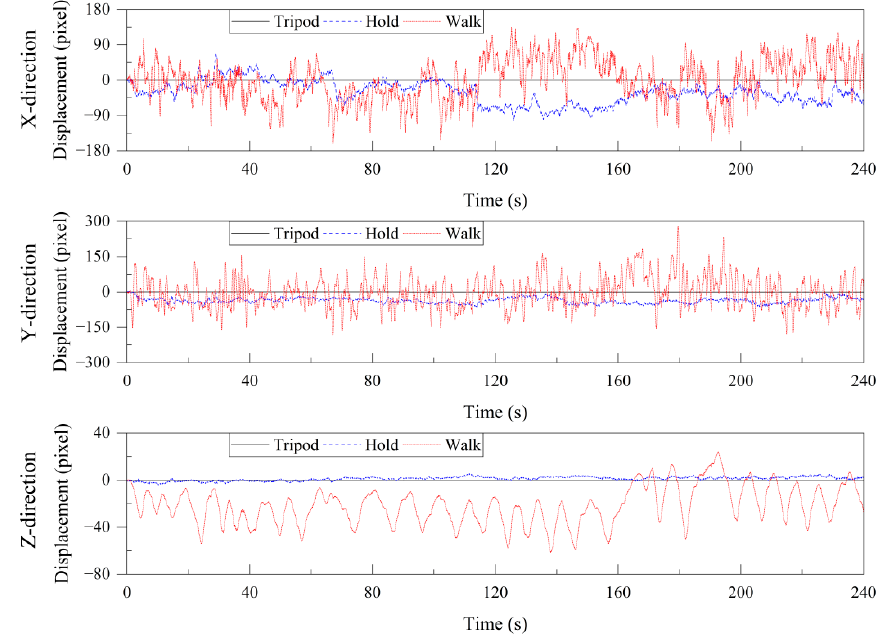
Figure 10. Directions for testers to take pictures and smartphones.